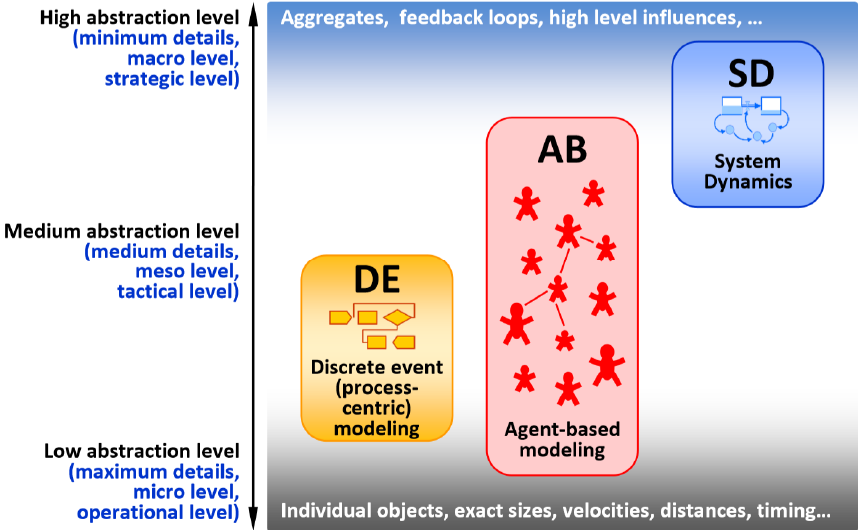
Figure 1. Categories of system modeling tools and levels of abstraction (from Borshchev and Grigoryev [5]).